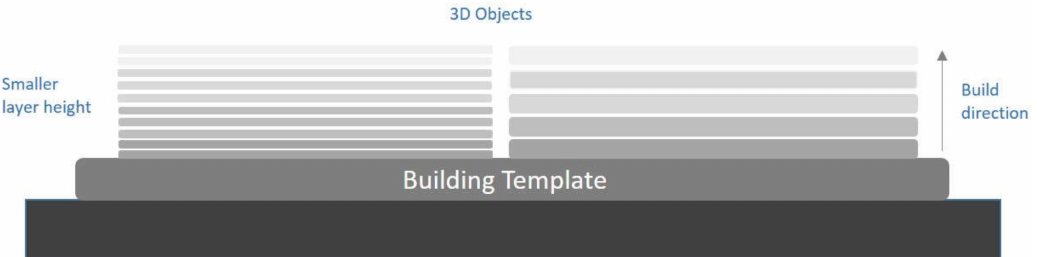
Figure 3. Layer height in 3D building